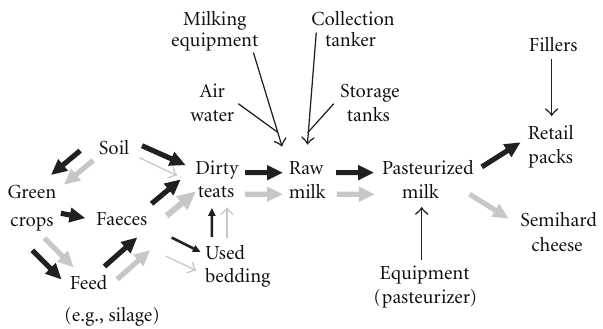
Figure 2: Contamination routes of spores of B. cereus (black arrows) and C. tyrobutyricum (grey arrows) in the dairy production chain. The importance of contamination sources and routes is indicated by the size of